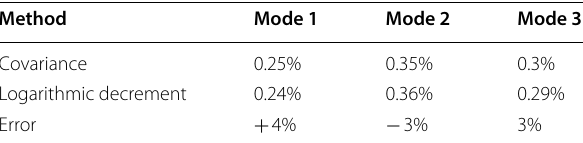
Table 6 Damping estimation using the derivative